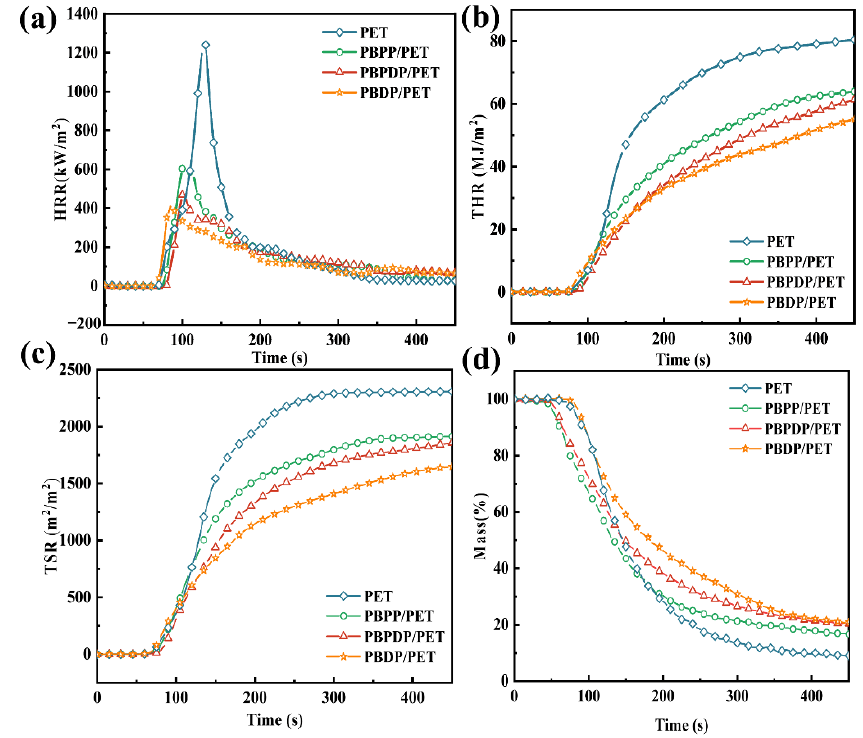
Figure 3. HRR ( a ), THR ( b ), TSR ( c ), and Mass ( d ) curves of PETs. Table 2. The detail information of the cone test.